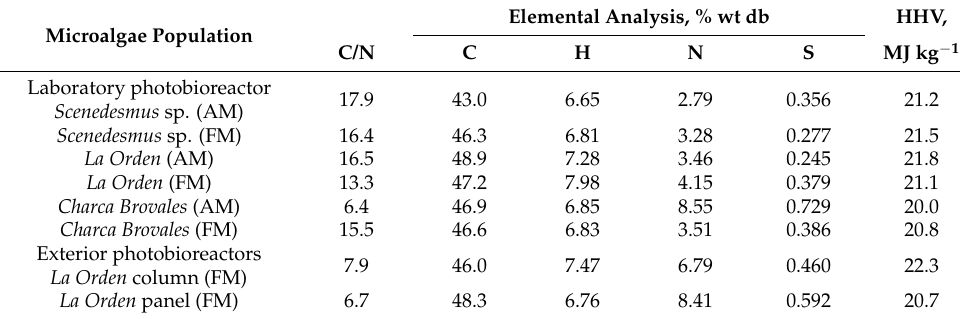
Table 3. Elemental analysis and HHV of the microalgae